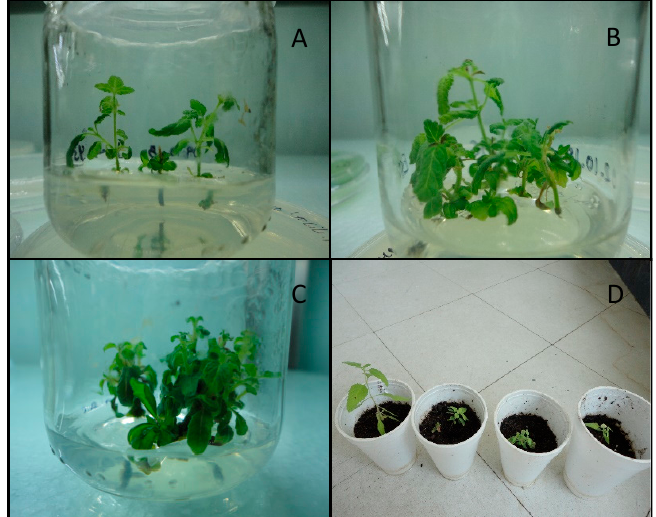
Figure 1. Production of shoots from axillary buds of Mexican oregano (genotype D) in MS medium, from the first sub-cultivation (A), second sub-cultivation (B), and third sub-cultivation (C); oregano established in soil under greenhouse conditions (D).